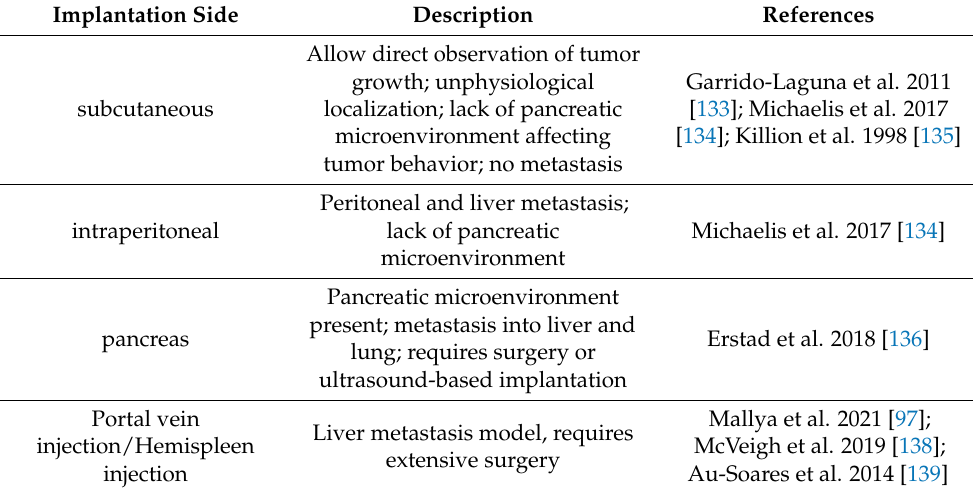
Table 4. Comparison of different injections in xenograft-mouse models of pancreatic cancer. Injection sides induce diverse characteristics with individual advantages and